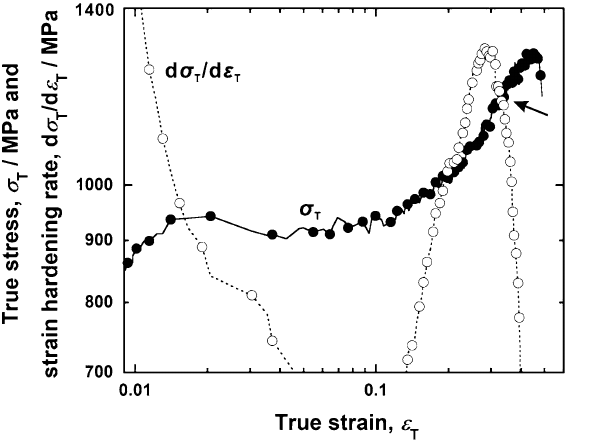
Figure 5. Relationship between true stress and strain hardening rate plotted against true strain for the taenite specimen. σ T and ε T were calculated using the following equations: σ T = σ (1 + ε ) and ε T = ln (1 + ε ). Since these equations can be applied in the case of isotropic shrinkage due to uniaxial deformation under the constant- volume deformation assumption, the calculations are invalid during local deformation regime and beyond the plastic